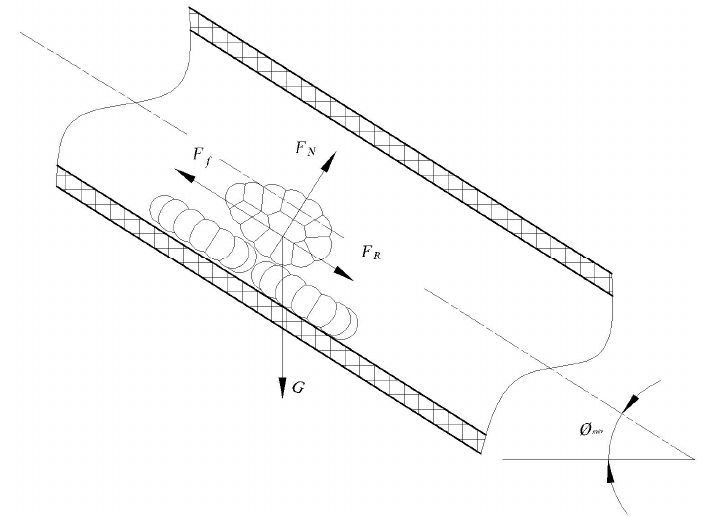
Figure 6. Mechanics analysis of seeds in seeding tube.